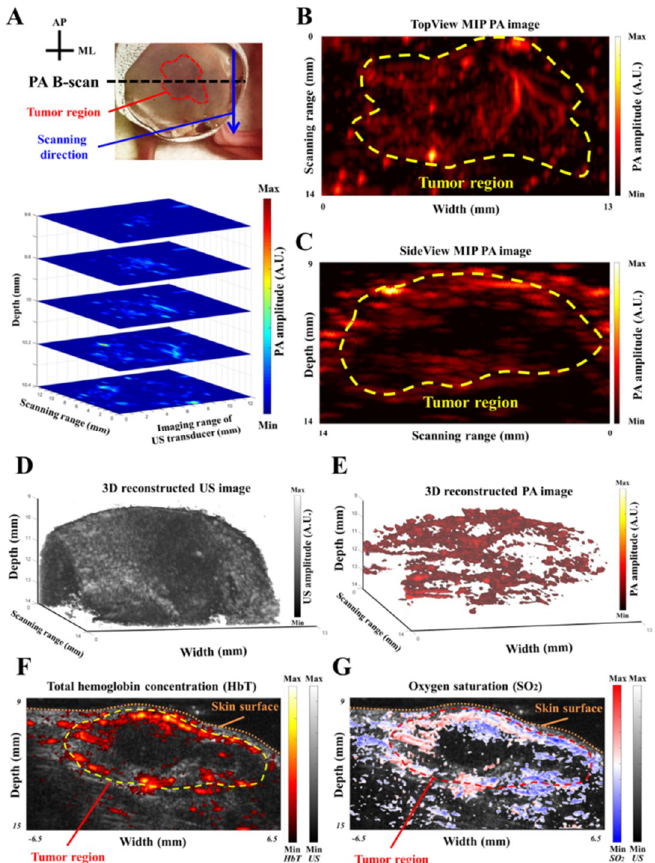
Figure 8. Subcutaneous tumor evaluation using the developed PA imaging system. ( A ) The tumor in the right hind leg was imaged by our PA imaging system. The upper subfigure shows that the tumor region (indicated by red dashed line) was scanned in the scanning direction (blue arrow) to acquire multiple X-Z plane PA B-scan images. The lower subfigure demonstrates the reconstructed 5-slice CBV C-scan images in the X-Y plane at different depths. ( B , C ) The TopView (X-Y plane) and SideView (Y-Z plane) MIP images of the subcutaneous tumor, respectively. Tumor regions are indicated by yellow dashed lines. ( D , E ) 3D reconstructed US and PA images of the subcutaneous tumor, respectively. ( F ) A normalized total hemoglobin concentration (HbT)-ultrasound (US) co-registered X-Z plane B-scan image. The distribution of HbT is highly correlated with the subcutaneous tumor profile acquired by US imaging. ( G ) A normalized oxygen saturation (SO 2 ) image of the subcutaneous tumor. Note that the yellow and red dashed lines indicate the tumor regions in ( F ) and ( G ),